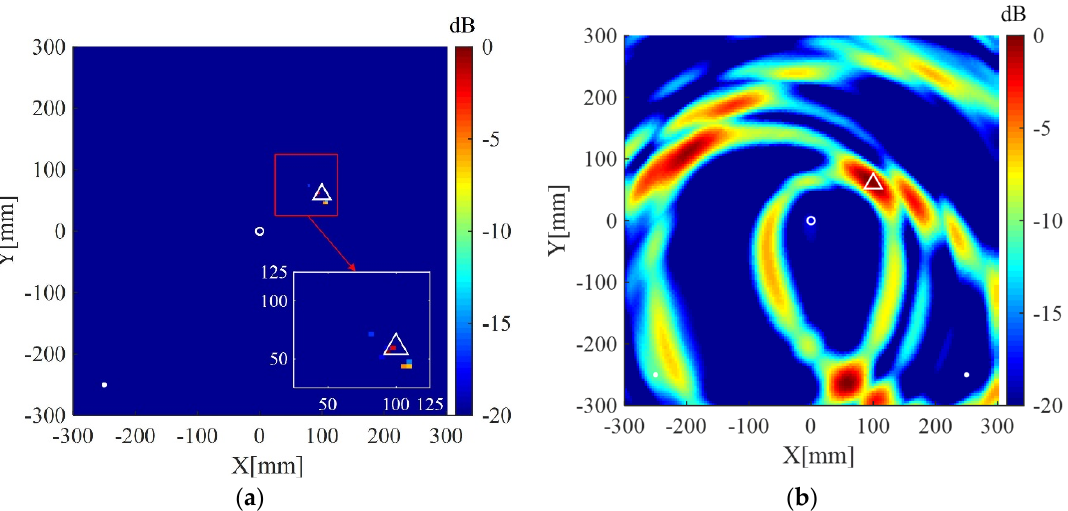
Figure 11. ( a ) Imaging result of the weighted structured sparse reconstruction-based Lamb wave imaging method using data from two receivers (the location error is 8 mm); ( b ) Imaging result of the delay-and-sum imaging method using data from two receivers (the location error is 324 mm). White dots denote locations of PZT receivers, the white circle denotes the location of the excitation source, and the white triangle denotes the location of the scatterer.